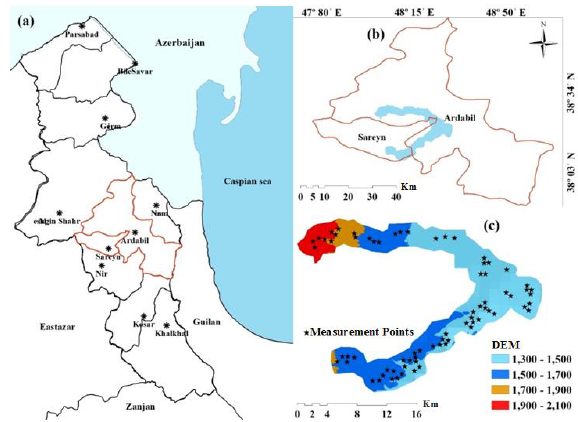
Figure 1 . Maps of Ardabil Province, NW Iran, showing the location of the two Ardabil and Sarein municipalities (a); geographical locations of the study area in the two municipalities (b); and spatial distribution of UV (A+B) and UV (C) solar irradiances measurement points in the study area